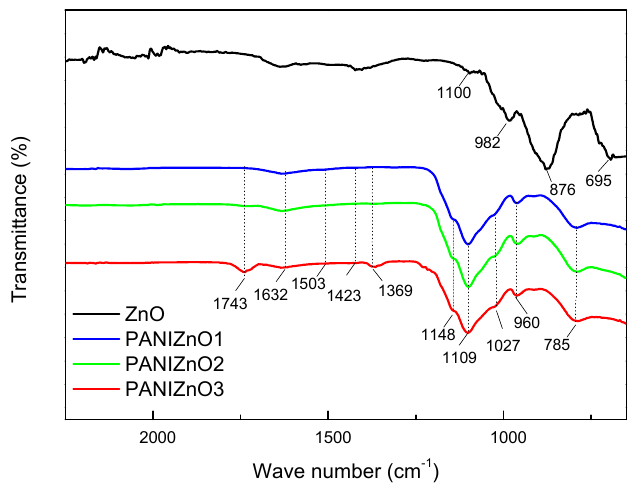
Figure 1. FTIR spectra of the pure ZnO and PANI/ZnO photocatalysts.